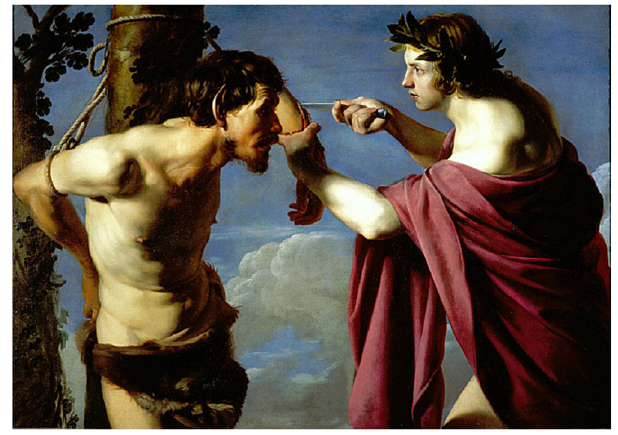
Figure 4: Bartolomeo Manfredi, Apollo and Marsyas , 1615 – 1620. St Louis Art Museum. Public